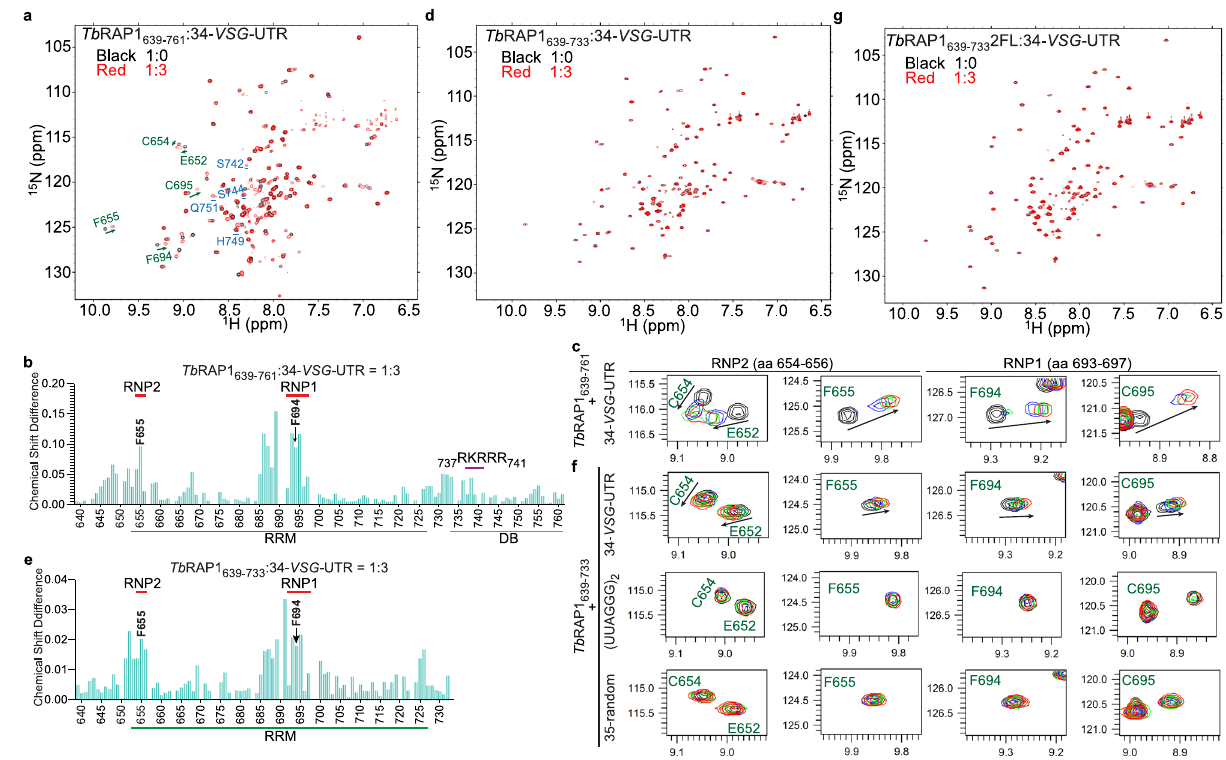
15 N-HSQCspectrain( a )highlightingchemicalshiftperturbationsforkeyresiduesin RRMintheabsence(black)andpresenceof34- VSG -UTRin1x(blue),2x(green)and 3× (red) molar excess. Residues located on RNP1 and RNP2 of RRM, including the conserved F655 and F694 are highlighted in ( c ). f Insets of overlaid 1 H- 15 N-HSQC spectra of 15 N-labeled Tb RAP1 639 – 733 in the absence (black) or presence of 34- VSG - UTR (top), (UUAGGG) 2 (middle), and 35-random (bottom) in 1x (blue), 2x (green) and3×(red)molarexcess.Highlightedresiduesarethesameasin( c ).Only34- VSG